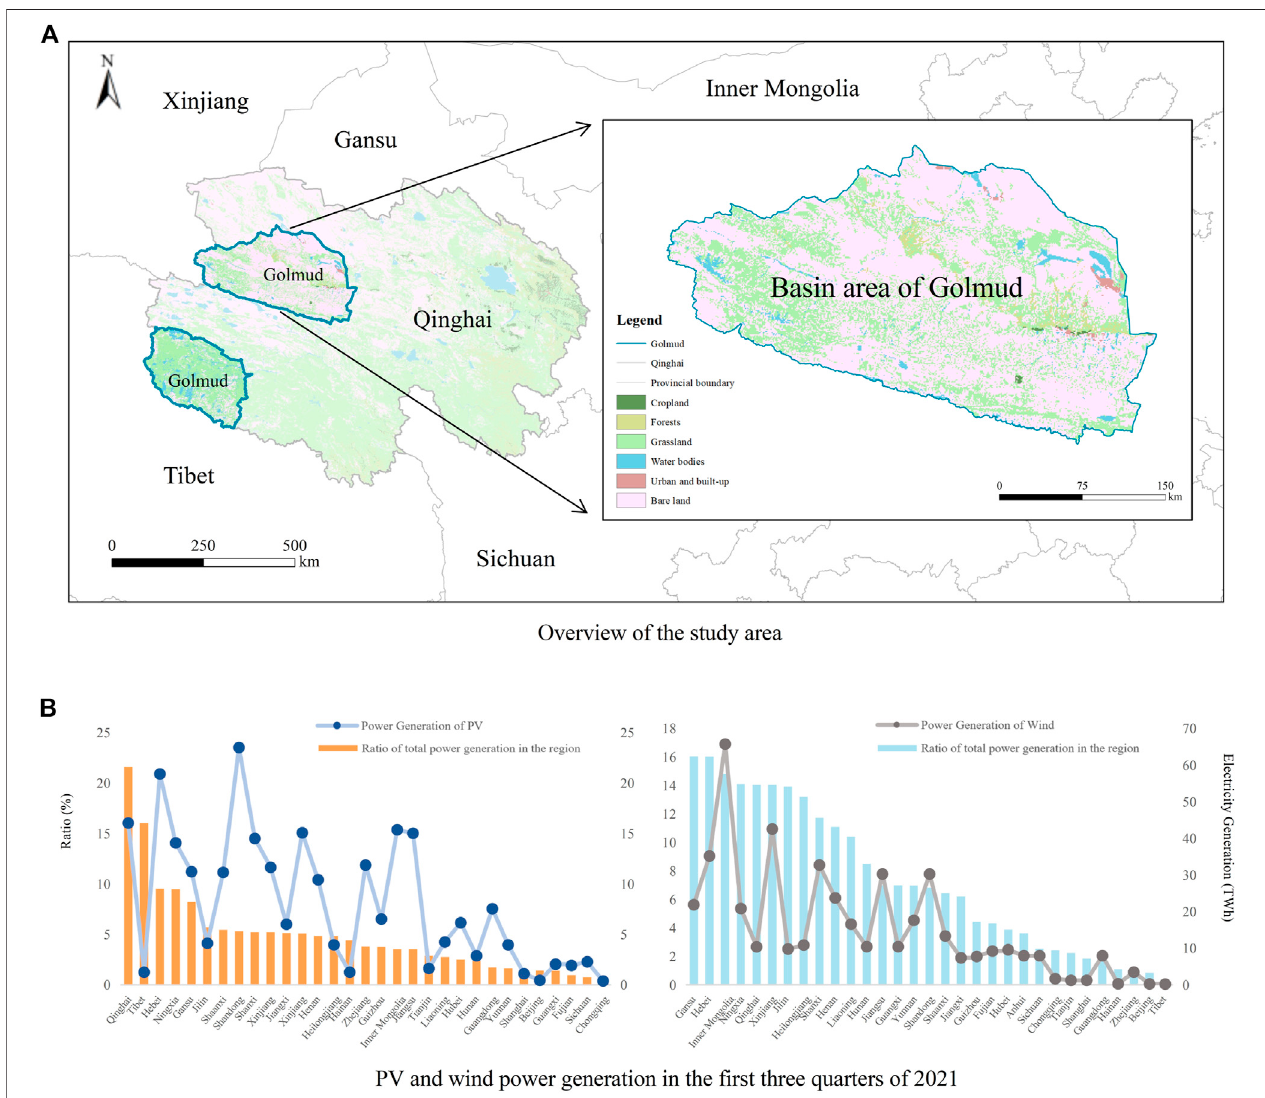
FIGURE 1 | Brief pro fi le of geographical information (A) and electricity generation (B) in the study region.